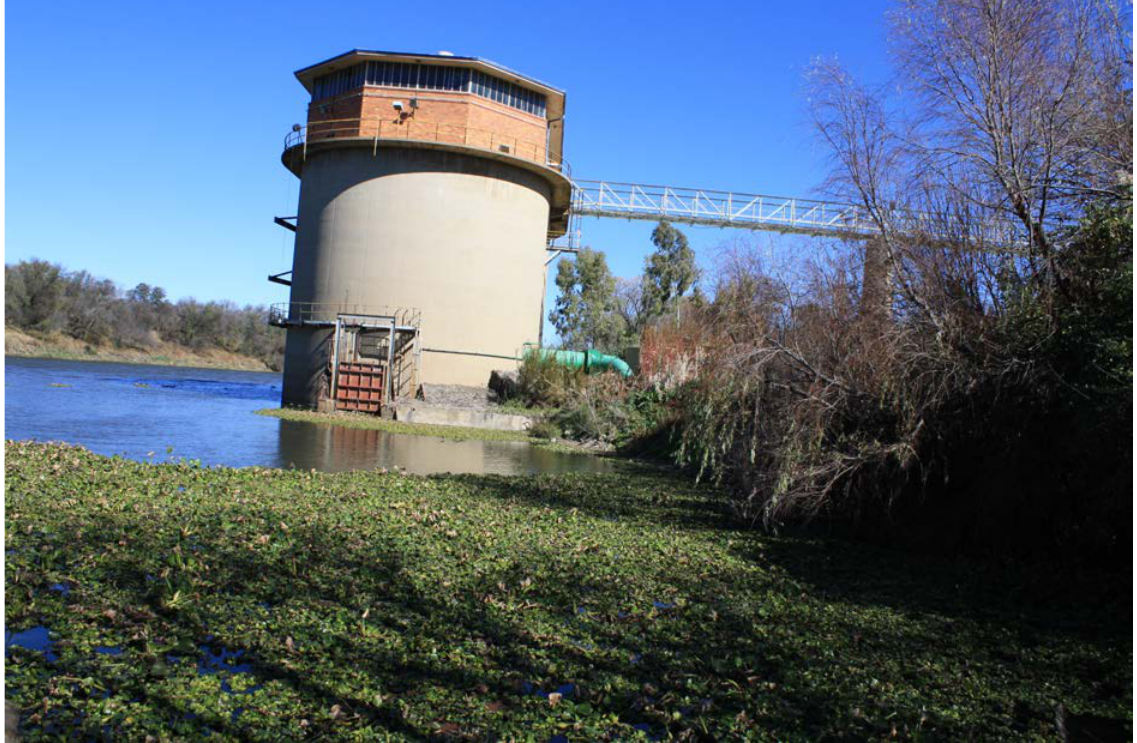
Illustration 5: Hyacinth in the Vaal River at the Midvaal Water intake in 2009.